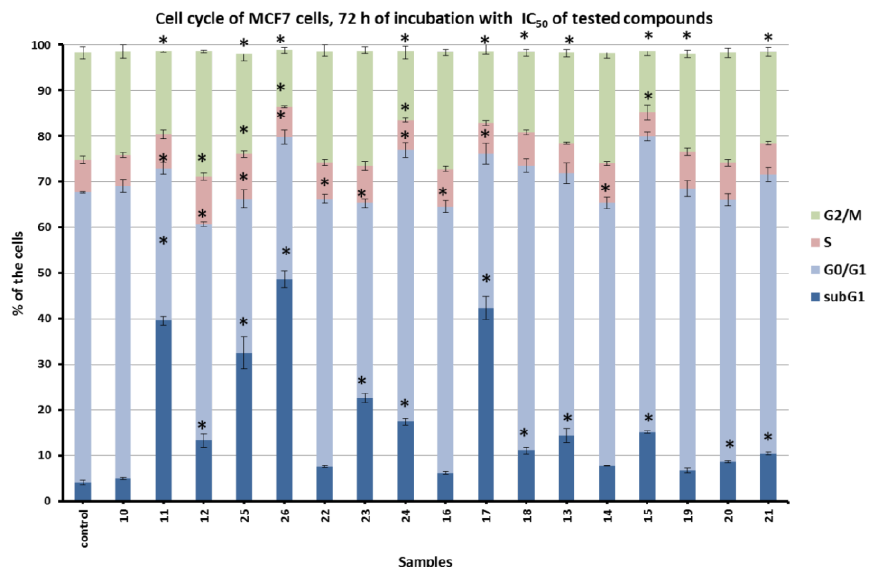
Figure 4. Cell cycle distribution in MCF-7 cells after 72 h of incubation with tested compounds at IC 50 dose or 100 µ M for no effective compounds, based on Table 2. The subG1 fraction represents apoptotic and dead cells. Results presented as mean of 3 experiments ± SD. Statistical significance indicated by star; evaluated by T-test, where p < 0.05.